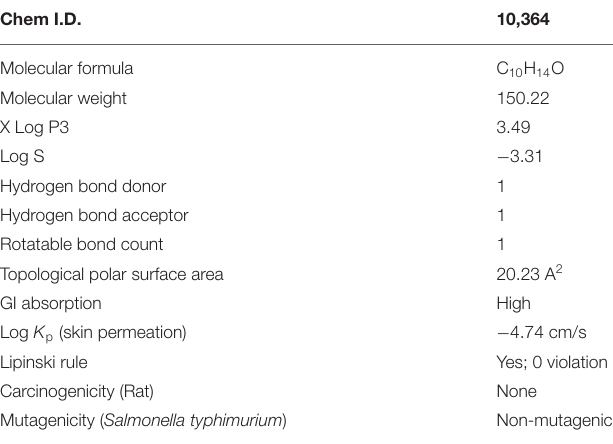
TABLE 5 | In silico prediction studies of carvacrol from SwissADME and Iazar. Chem